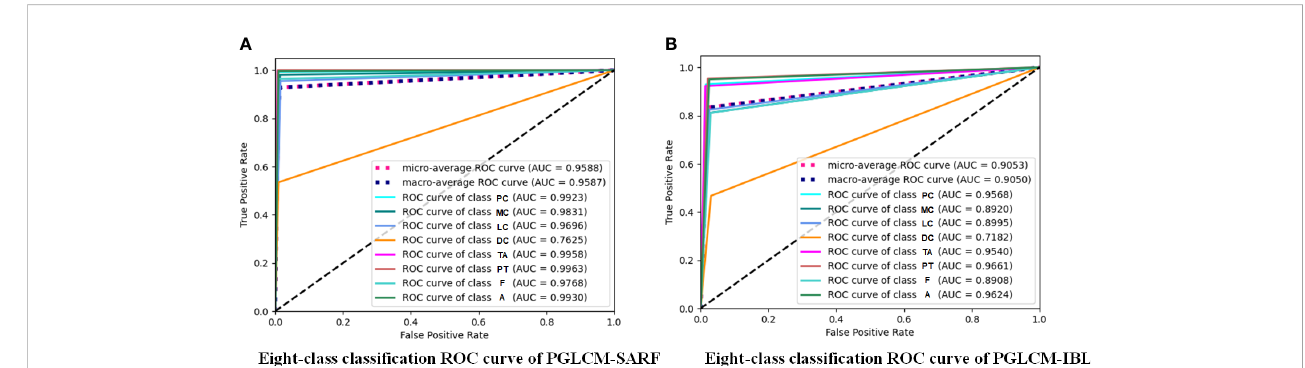
FIGURE 9 ROC curves of PGLCM-SARF and PGLCM-IBL for eight-class classi fi cation results. (A) Eight-class classi fi cation ROC curves of PGLCM-SARF; (B) Eight- class classi fi cation ROC curves of PGLCM-IBL.